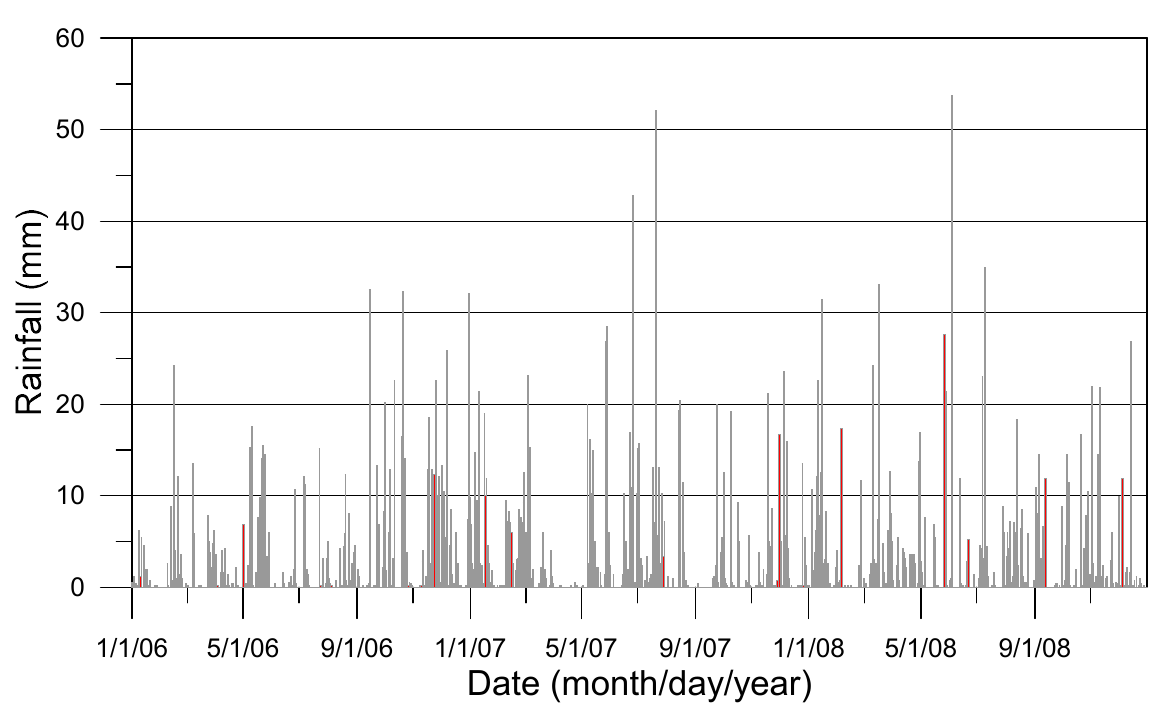
Figure 4. Measured daily rainfall at Newbury cutting.